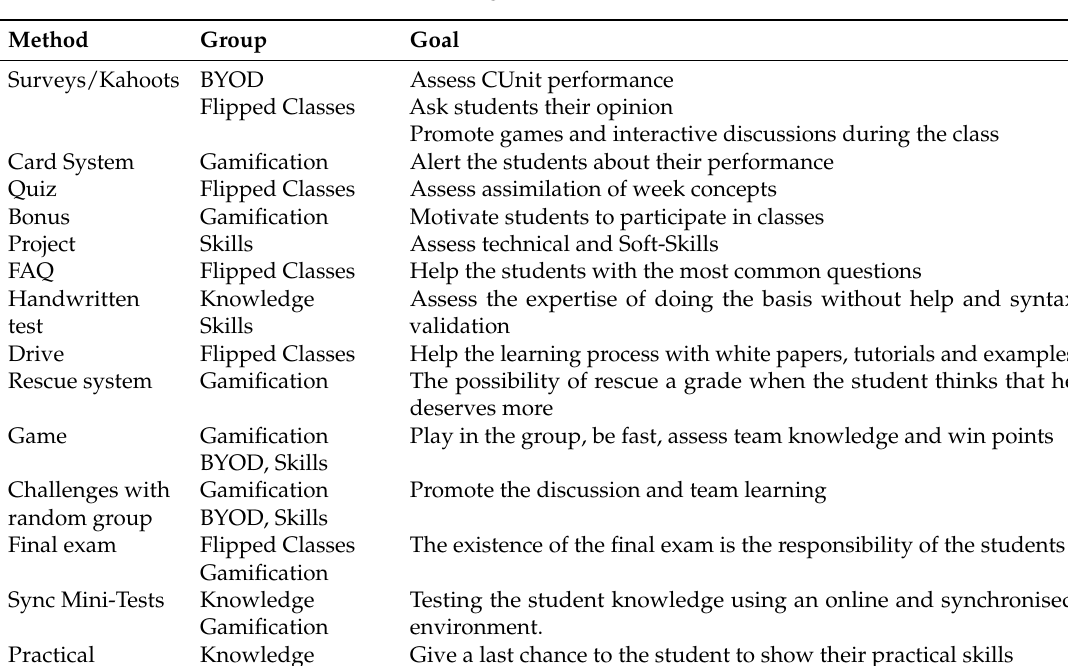
Table 4. Learning and assessment